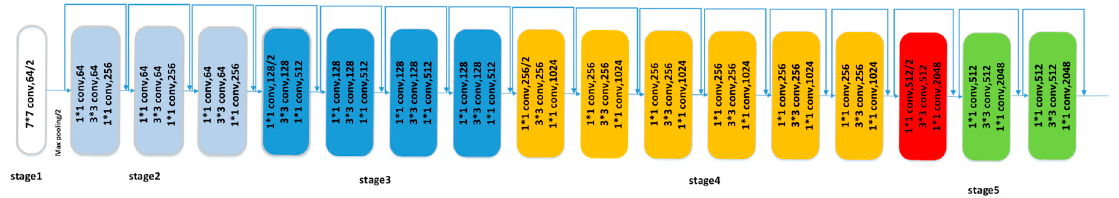
Figure 4. The architecture of the ResNet50 network in this paper.